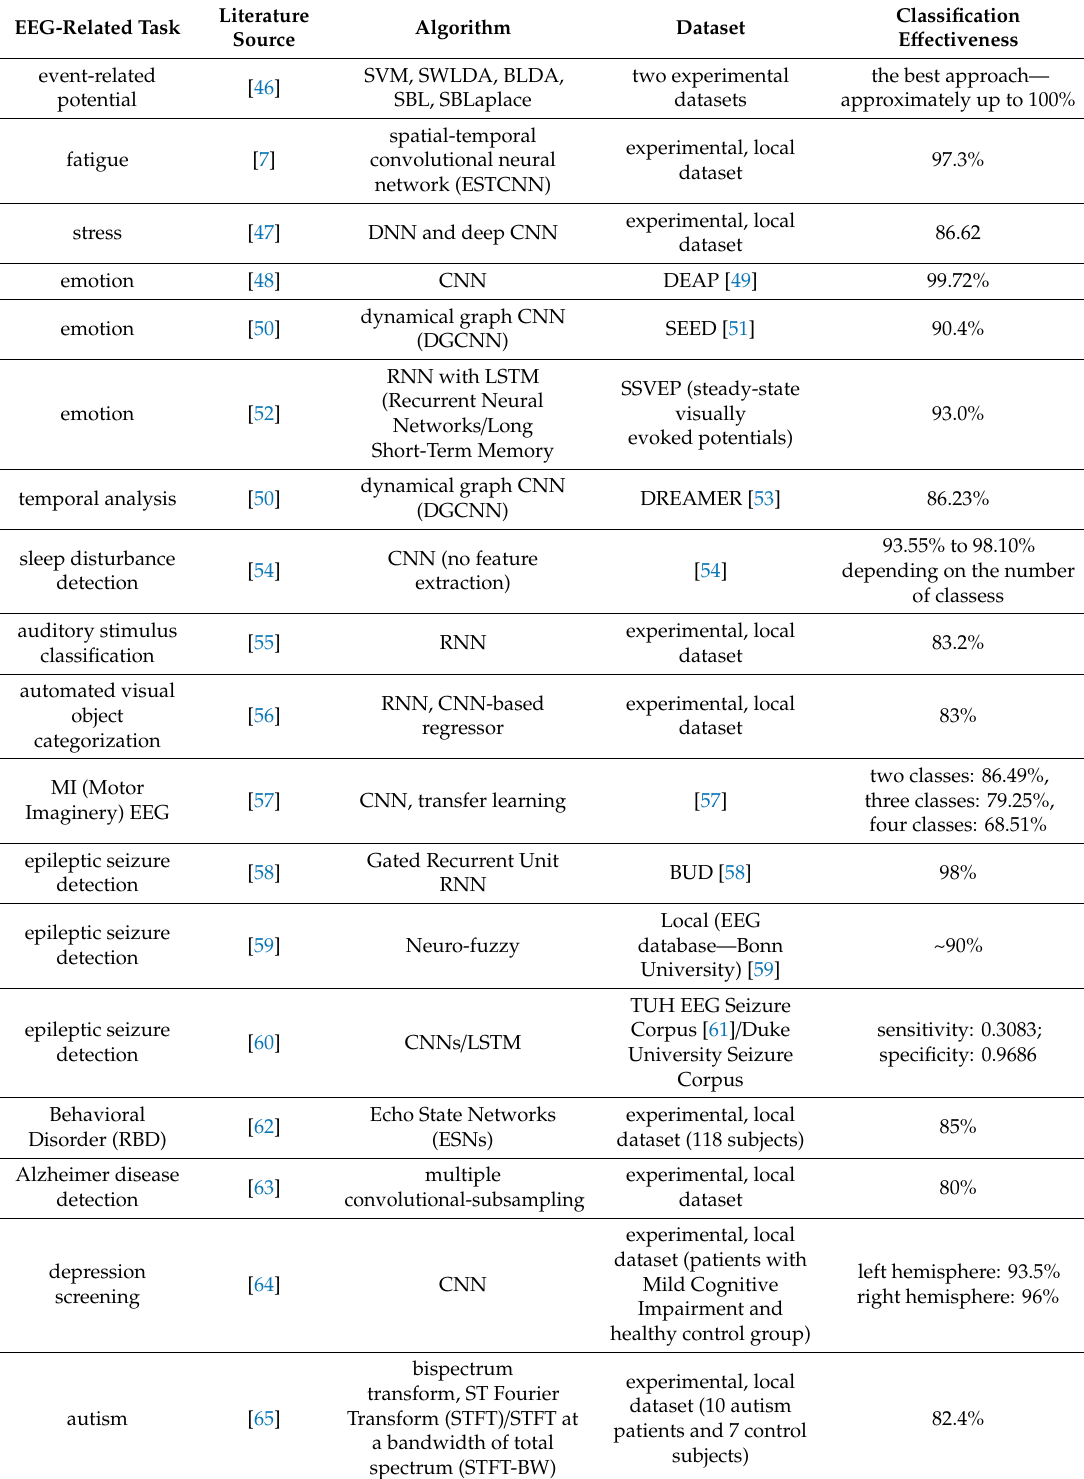
Table 1. Examples of classification performance obtained for various tasks based on selected literature